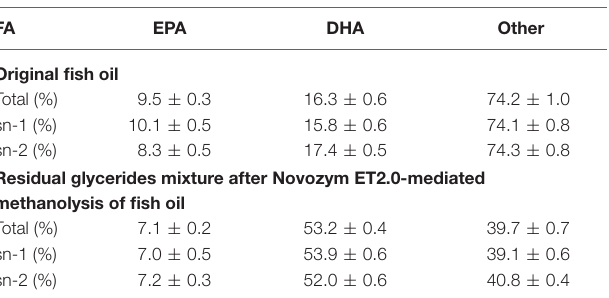
TABLE 2 | Analysis of positional distribution of FAs.